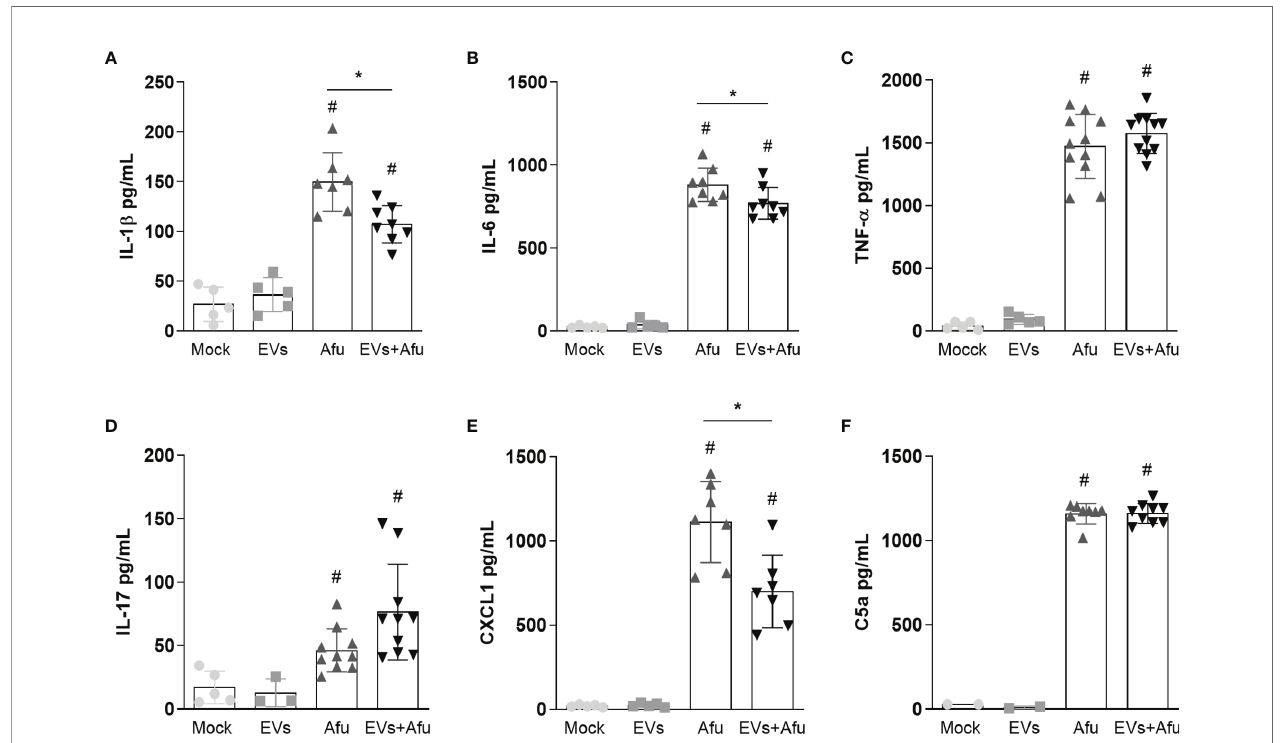
FIGURE 2 | Immunization with A. fumigatus EVs decreases the pro-in fl ammatory mediator ’ s production during infection. C57BL/6 mice were immunized twice with 2.2 × 10 9 EVs and challenged with 1 × 10 8 A. fumigatus conidia. The in fl ammatory mediators IL-1 b (A) , IL-6 (B) , TNF- a (C) , IL-17 (D) , CXCL1 (E) and C5a (F) presents in BAL from animals were quanti fi ed. Data are mean ± SD of N = 5-6 animals per group. #/* P < 0.05 when compared to the Mock group (#) or as indicated (*), as determined by One Way-ANOVA. Data are representative of two